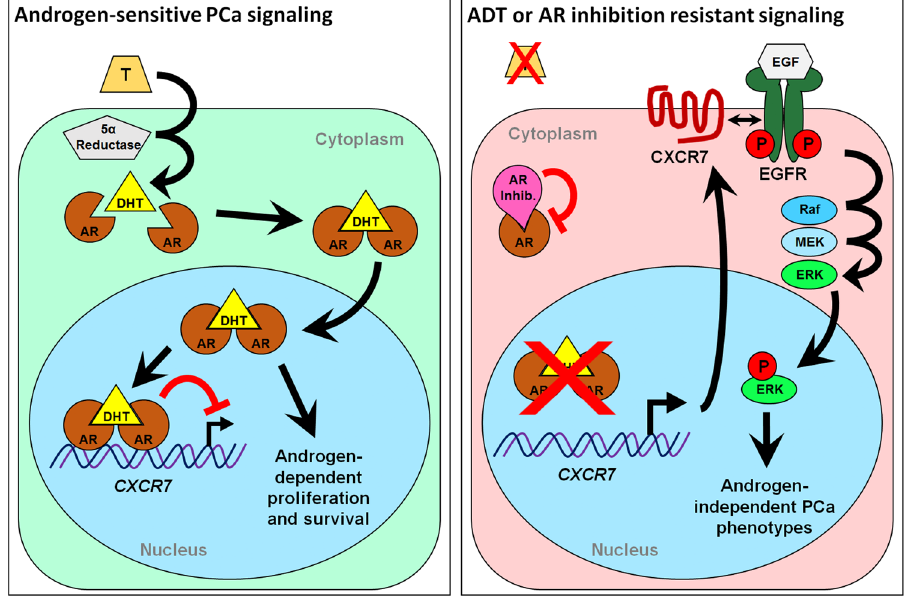
Figure 7. Illustration of the proposed prostate cancer cell signaling programs with or without normal androgen stimulation. Left: normal androgen signaling (testosterone [T] converted to dihydrotestosterone [DHT] and AR activation) suppresses CXCR7 expression while driving androgen-dependent proliferation mechanisms. Right: CXCR7 repression is removed during androgen deprivation therapy (ADT) or with chemical AR inhibition, facilitating EGF-mediated, androgen-independent cell survival and proliferation, and mechanisms of therapeutic